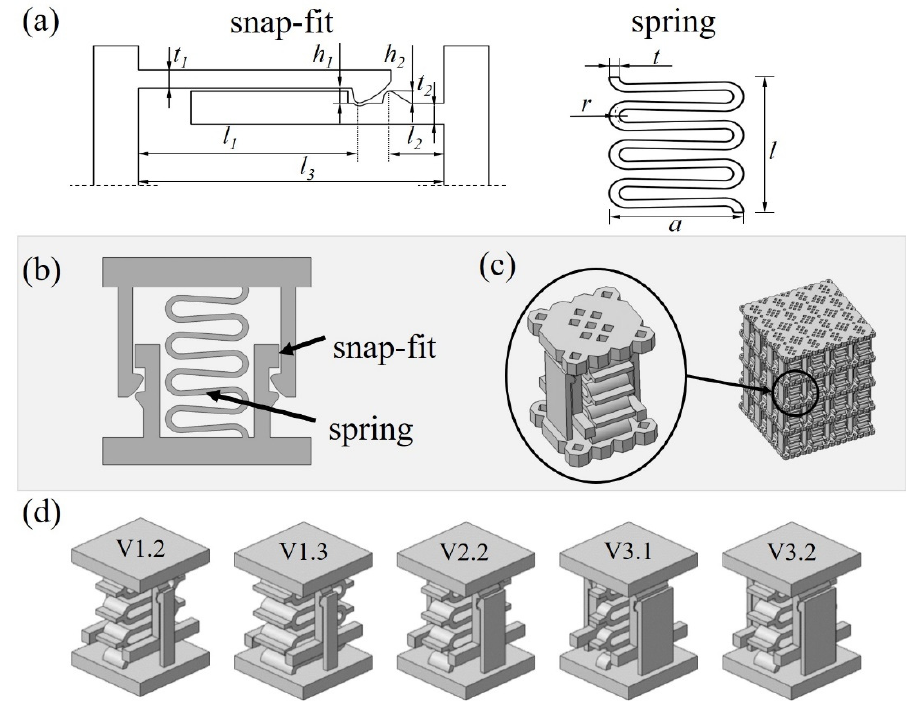
Figure 1. ( a ) Main mechanisms of the unit cell and design parameters, parameter set described be- low in the main text, ( b ) 2-D concept of the reversible energy absorbing metallic unit cell consisting of the spring and snap-fit mechanism, ( c ) fabrication model of the unit cell and metamaterial assembly, ( d ) cell configurations with varied spring and snap-fit width as variable factors. The designation VA.B corresponds to: A—the snap-fit width and B—the spring width with 1.5 mm (1), 3 mm (2), and 4.5 mm (3).